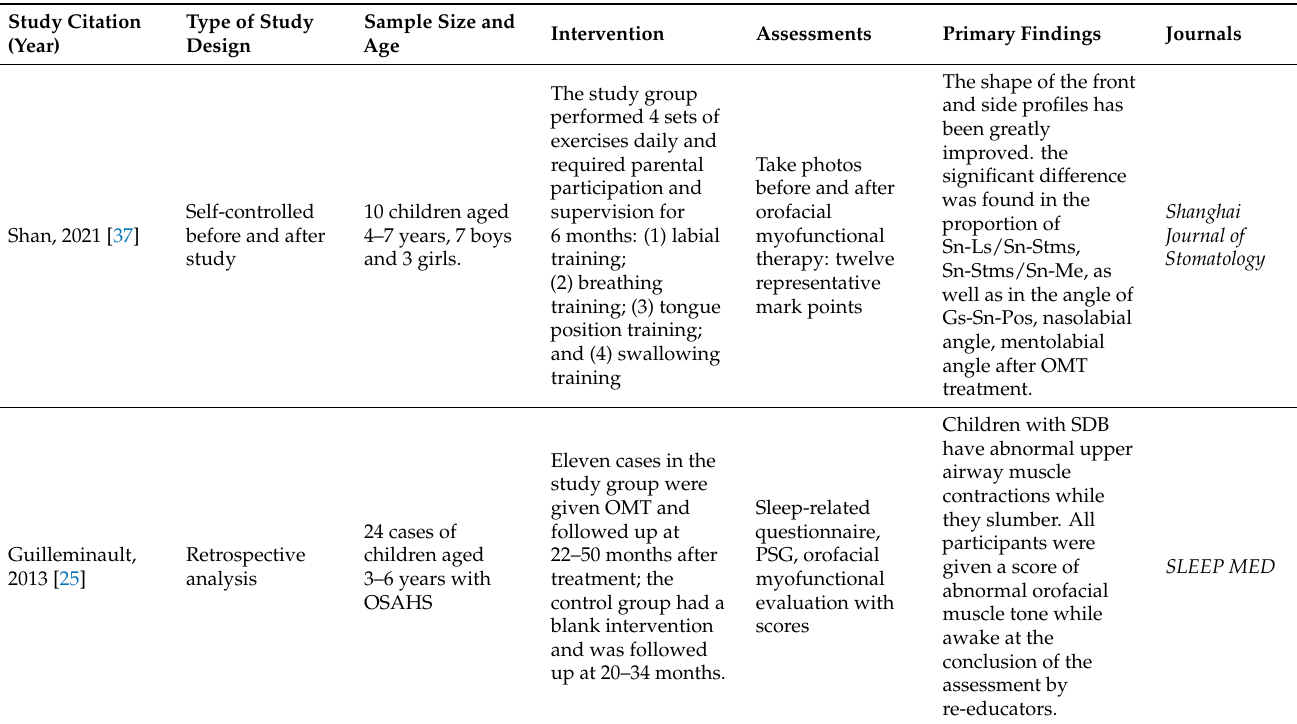
Table 2. Characteristics of the included